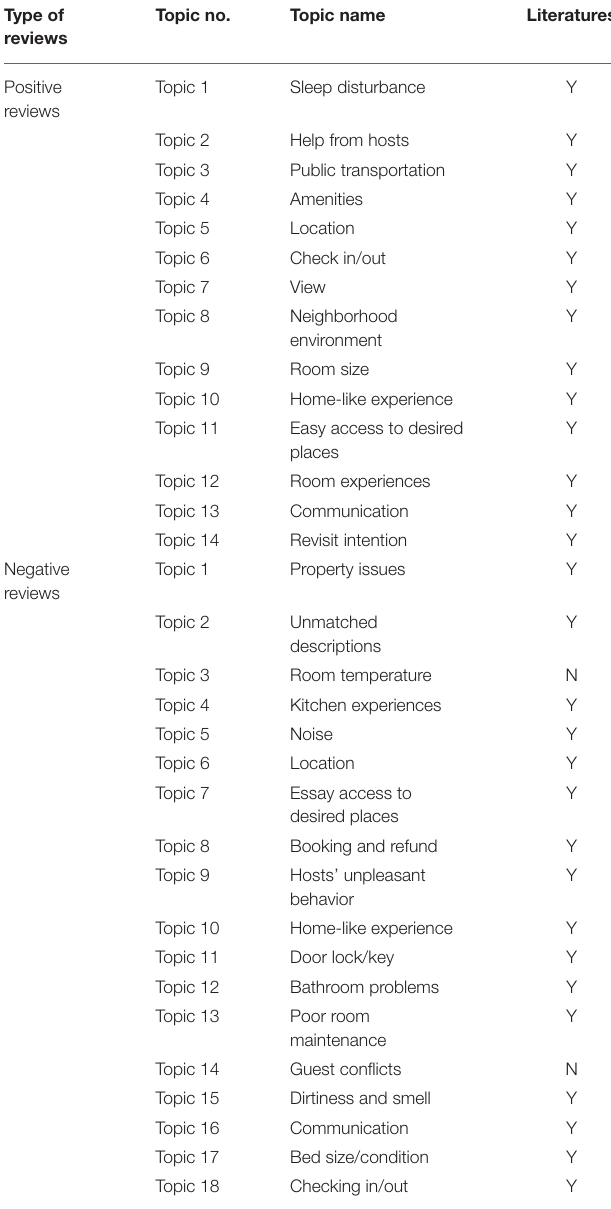
TABLE 3 | Topic label. Type of